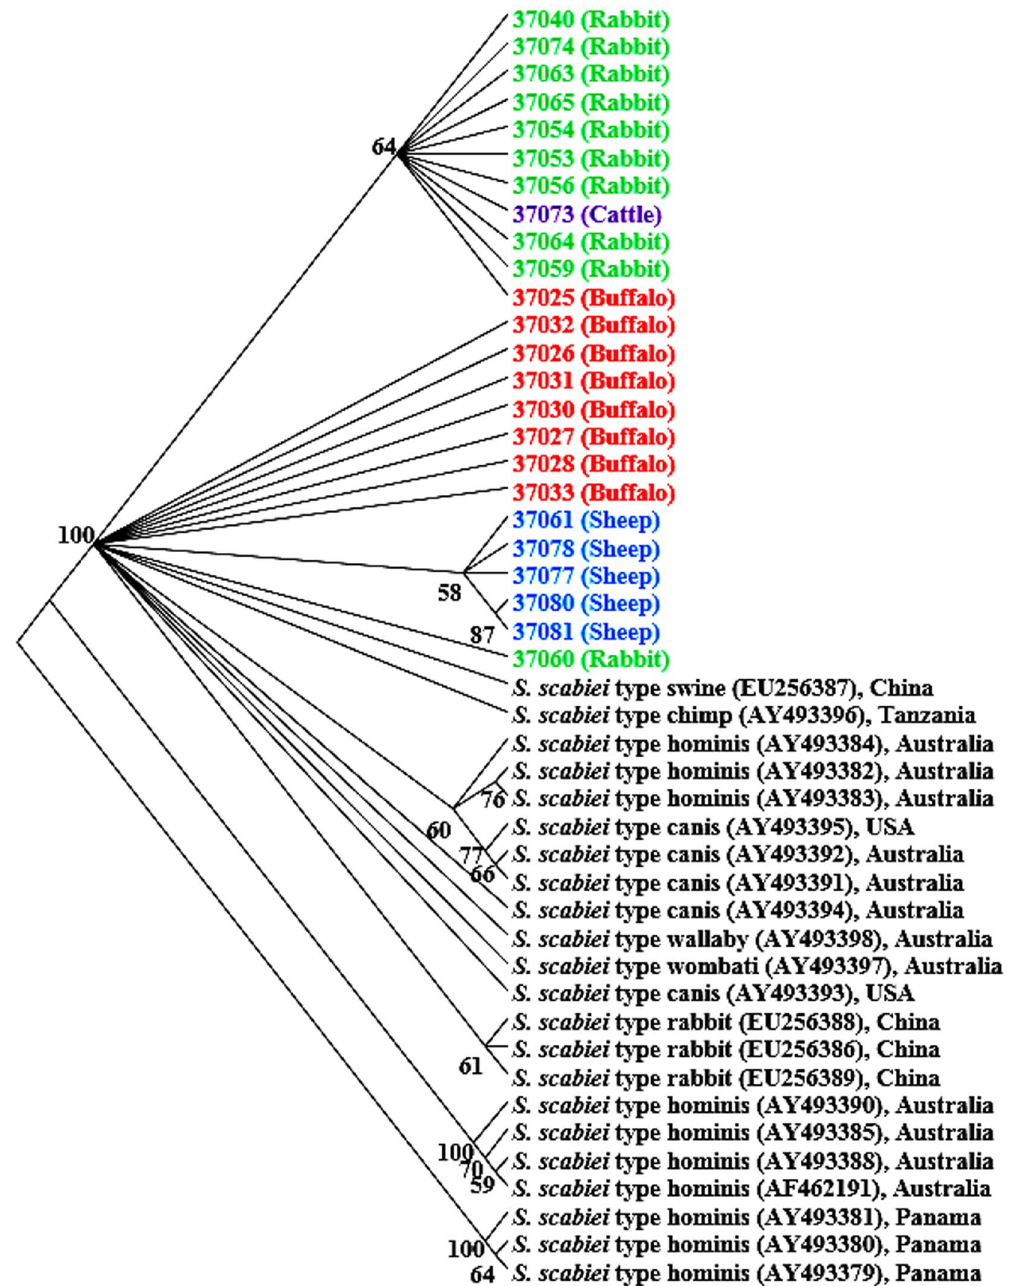
Figure 2. Un-rooted NJ tree showing genetic relationship of Egyptian Sarcoptes mites to others in the GenBank database based on COX1 sequences. Evolutionary relationships of 46 taxa were inferred using the neighbor-joining method [46]. Numbers at the internodes correspond to percent bootstrap values from 2,000 replicates. Branches corresponding to partitions produced in less than 50% bootstrap replicates are collapsed. Sequences in bolded colors and with no GenBank accession numbers are generated from Egyptian specimens.